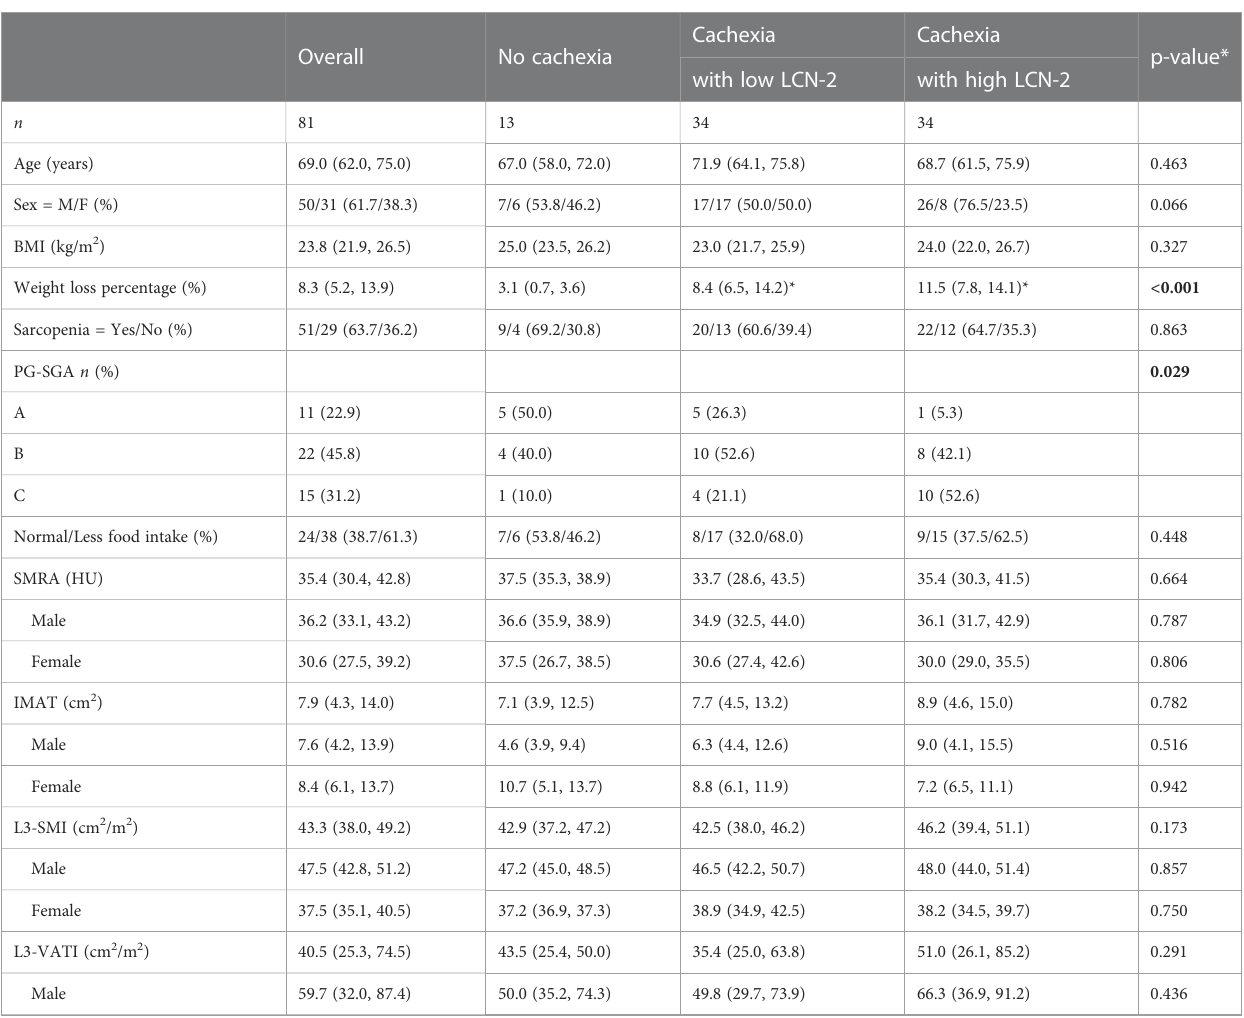
TABLE 1 General characteristics of included